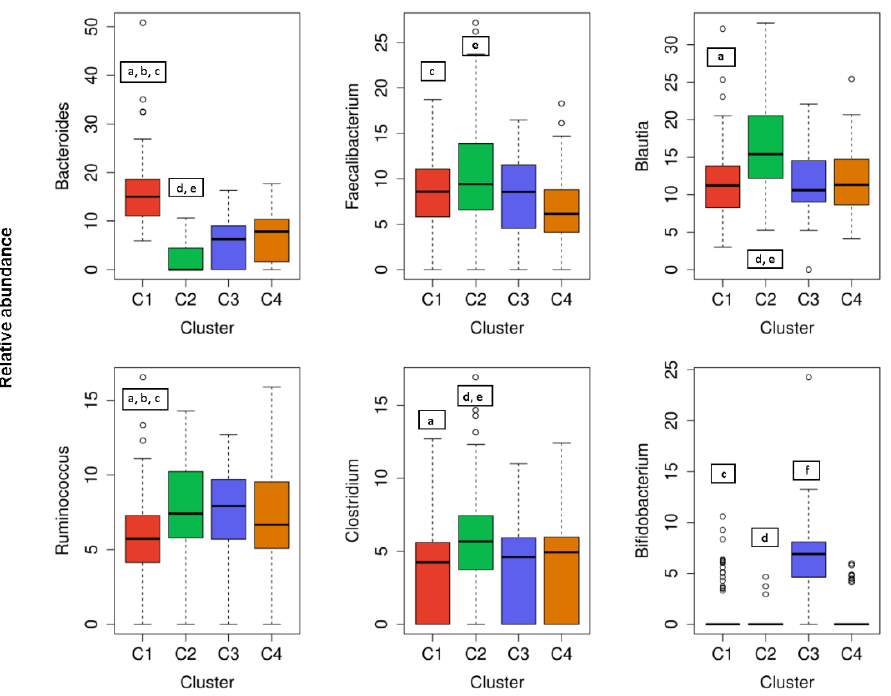
Figure 4. The cluster distribution of six most abundant bacterial and genera. Relative abundance per cluster of the six most abundant bacteria genera present in our cohort. Each box shows the median plus interquartile range of the relative abundance of bacterial genera. Colors show the cluster. Statistical significance differences ( p < 0.05) between clusters in each genus are presented with symbols a, b, c, d, e, and f: a, statistical significance ( p < 0.05) between C1 and C2. b, statistical significance ( p < 0.05) between C1 and C3. c, statistical significance ( p < 0.05) between C1 and C4. d, statistical significance ( p < 0.05) between C2 and C3. e, statistical significance ( p < 0.05) between C2 and C4. f, statistical significance ( p < 0.05) between C3 and C4.